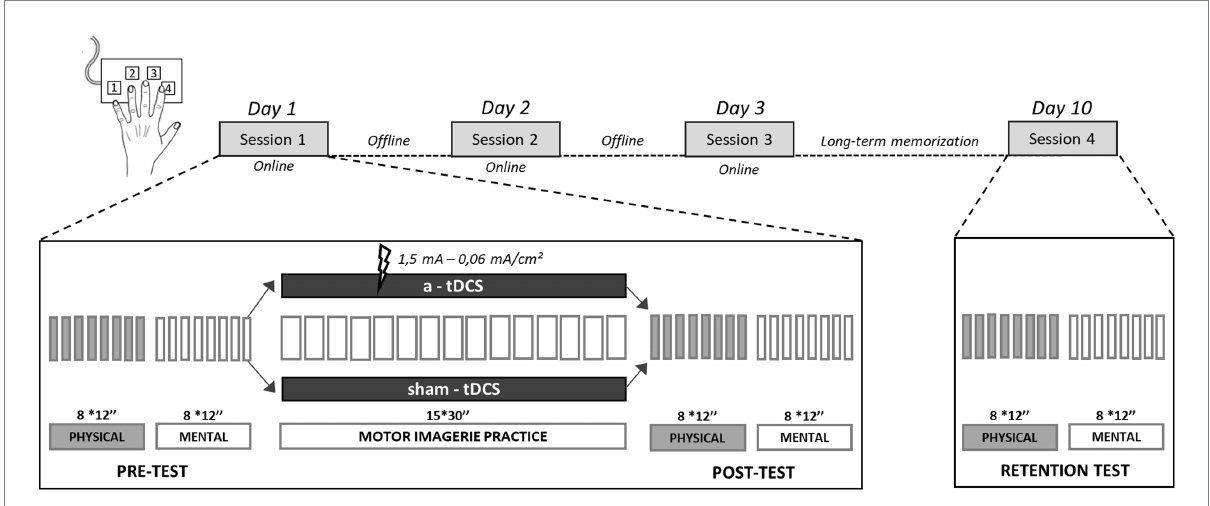
FIGURE 1 Task and training. The experiment consisted in three consecutive and identical training sessions (sessions 1, 2, and 3) over 3 days followed by a retention test (session 4), 1 week later. The evolution of intra-session performance represented the online learning, and the evolution of inter-session performance represented the offline learning. During each session, participants performed with their left hand an eight-item finger tapping sequence on a gaming keypad: 1-3-4-2-1-4-2-3. Before (pre-test) and after (post-test) MIP, as well as during the retention test, participants had to physically and mentally repeat the sequence, as fast and accurately as possible, during 8 blocks of 12 s (interspaced with 8 s of rest). During MIP, participants mentally rehearsed the sequence, as fast and accurately as possible, during 15 blocks of 30s interspaced with 20s of rest, with either concomitant a-tDCS or